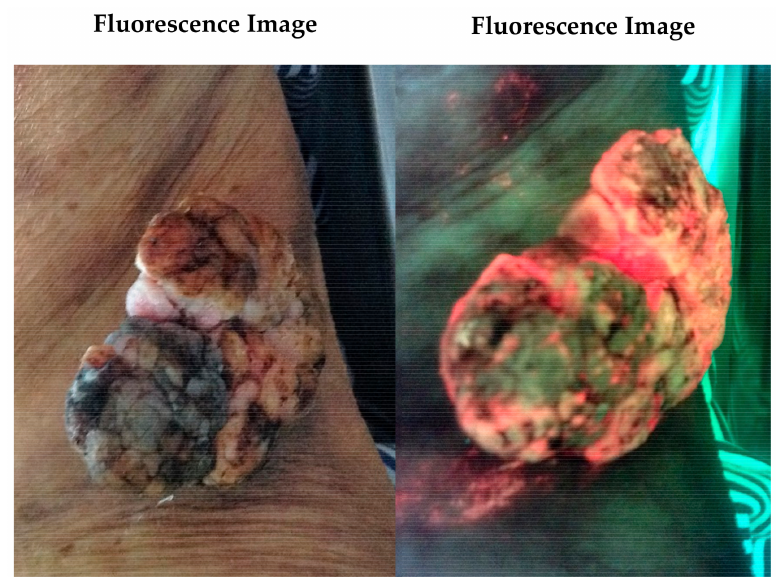
Figure 3. Case Study 1—Infected Cancerous Lesion. Fluorescence imaging of this skin cancer growth demonstrated areas of red bacterial fluorescence. Before excision of the growth, image- informed cleaning was performed to maximally remove bacterial loads and avoid wound infection. Microbiology: Staphylococcus